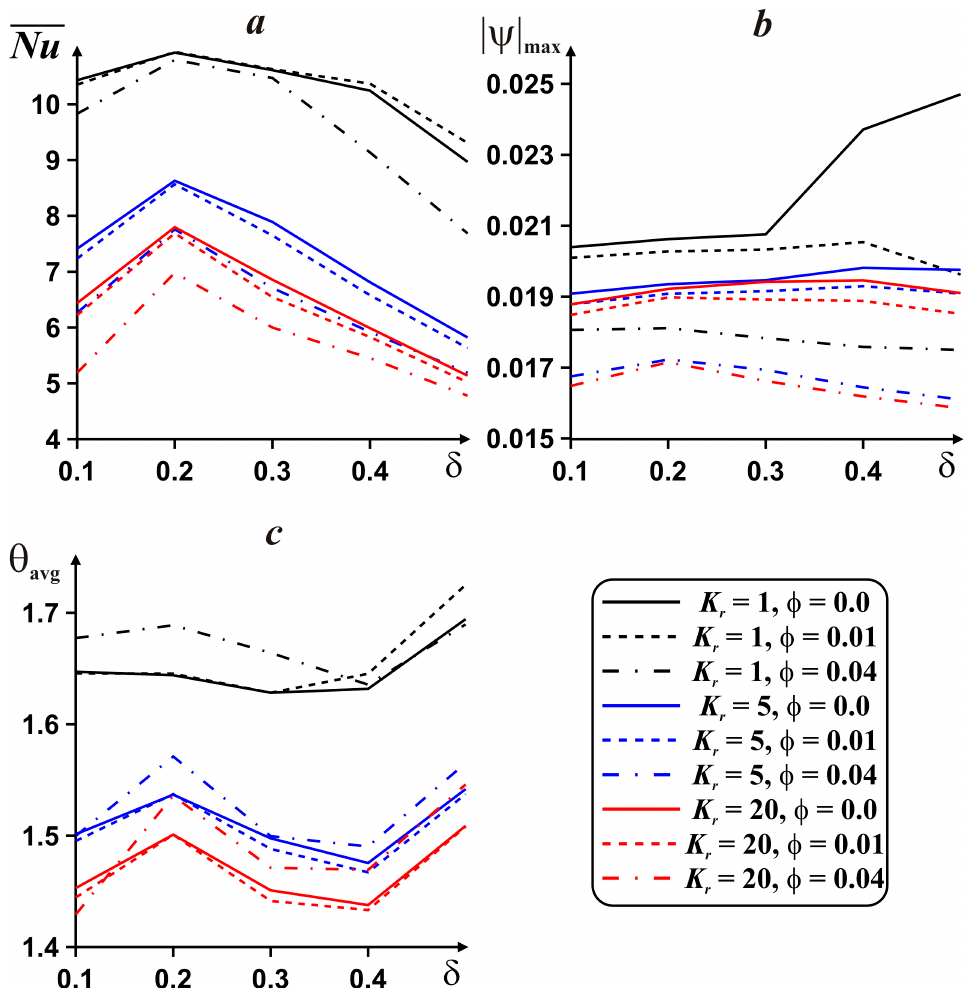
Figure 12. Dependences of the average Nusselt number ( a ), nanoliquid circulation rate ( b ) and mean heater temperature ( c ) on the heater location, K r and φ for Ra = 10 5 .